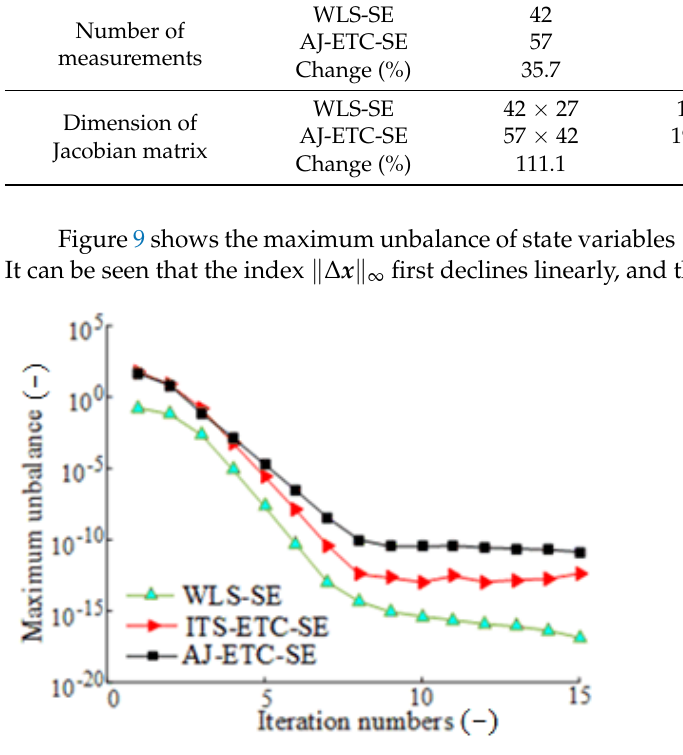
Figure 9. Maximum unbalance of state variables.